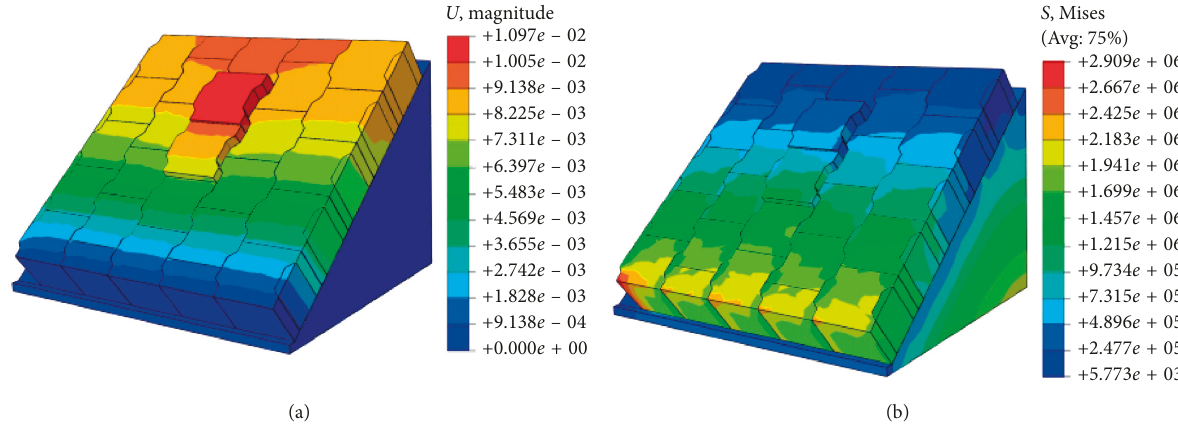
Figure 16: Cloud diagram of numerical simulation results of traditional block 2 revetment. (a) Equivalent displacement nephogram. (b) Equivalent stress